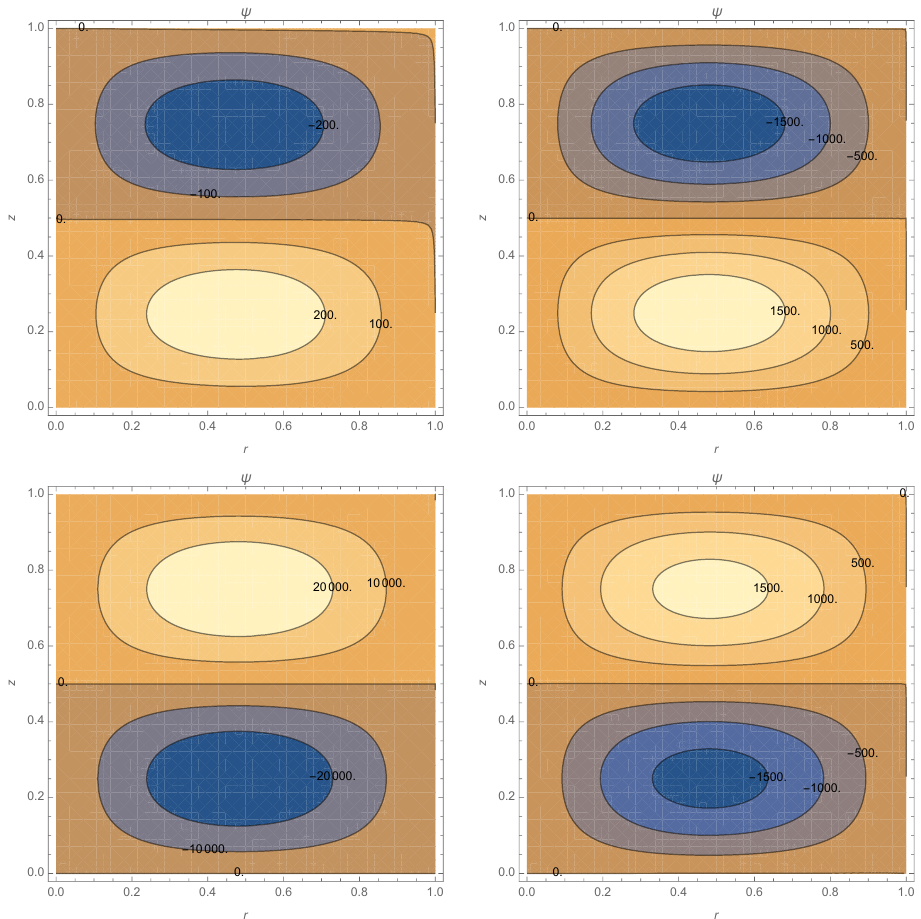
Figure 6. Study of the resonance around λ = 7.35937: 7.3 ( upper left panel ), 7.35 ( upper right panel ), 7.36 ( bottom left panel ), 7.37 ( bottom right panel ). See text for